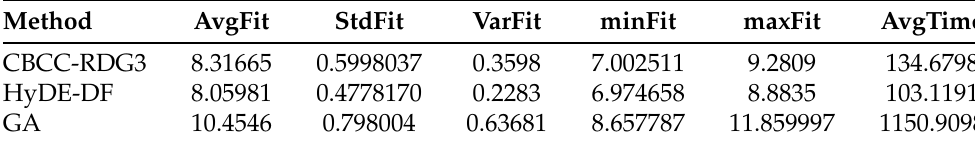
Table 2. Common results for CBCC-RDG3 , HyDE-DF and GA .